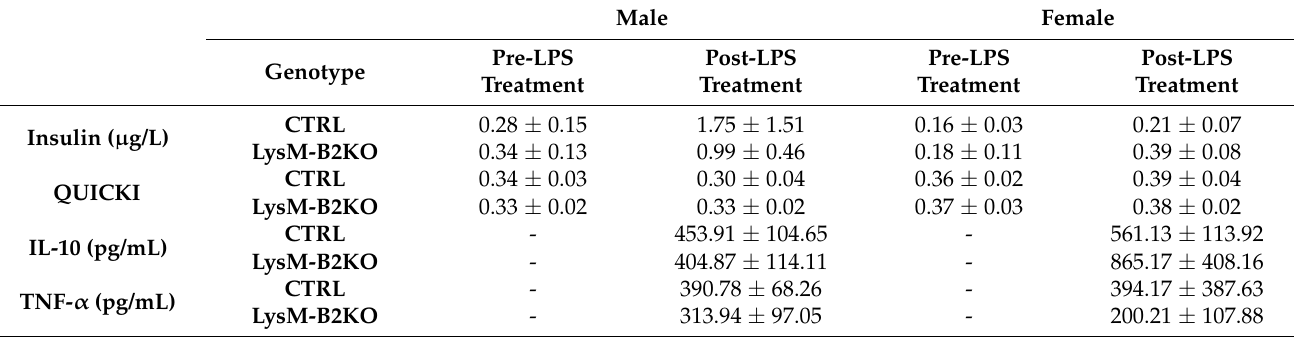
Table 1. Insulin, quantitative insulin sensitivity check index (QUICKI) and cytokine multiplex analysis of serum in LysM- B2KO mice fasted for 5 h and subjected to 1 mg/kg LPS for 3 h (female n = 5–7, male n = 7–10). Data are represented as mean ±